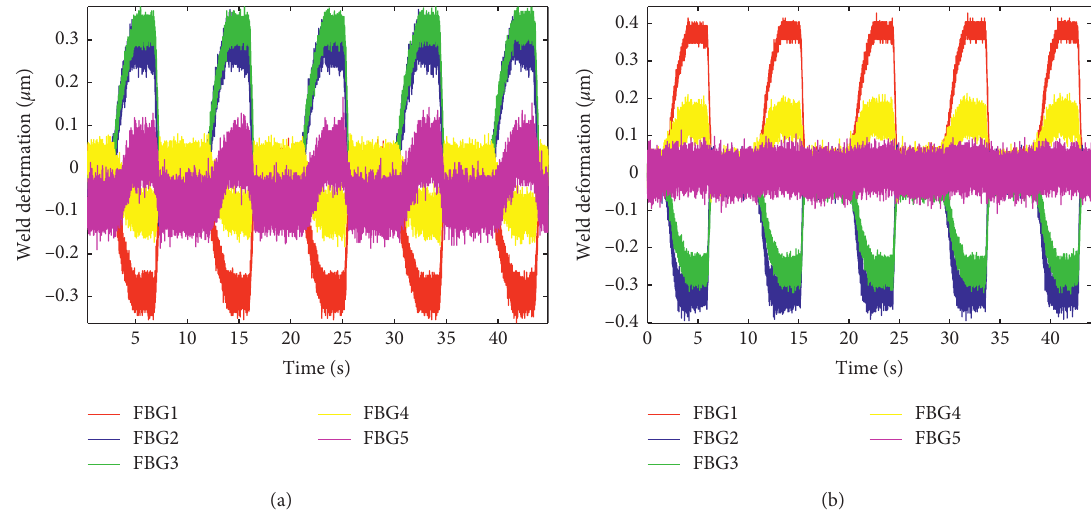
Figure 9: Cycle loading test with the top beam at a low position. (a) The block on the left side. (b) The block on the right side.